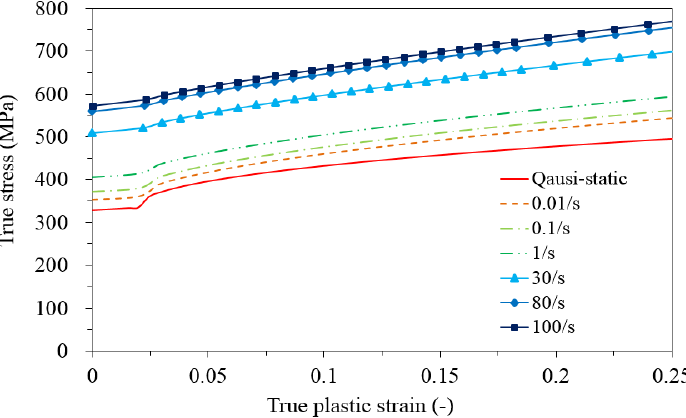
Figure 20. A typical true stress–strain curve applied for the FE analysis.